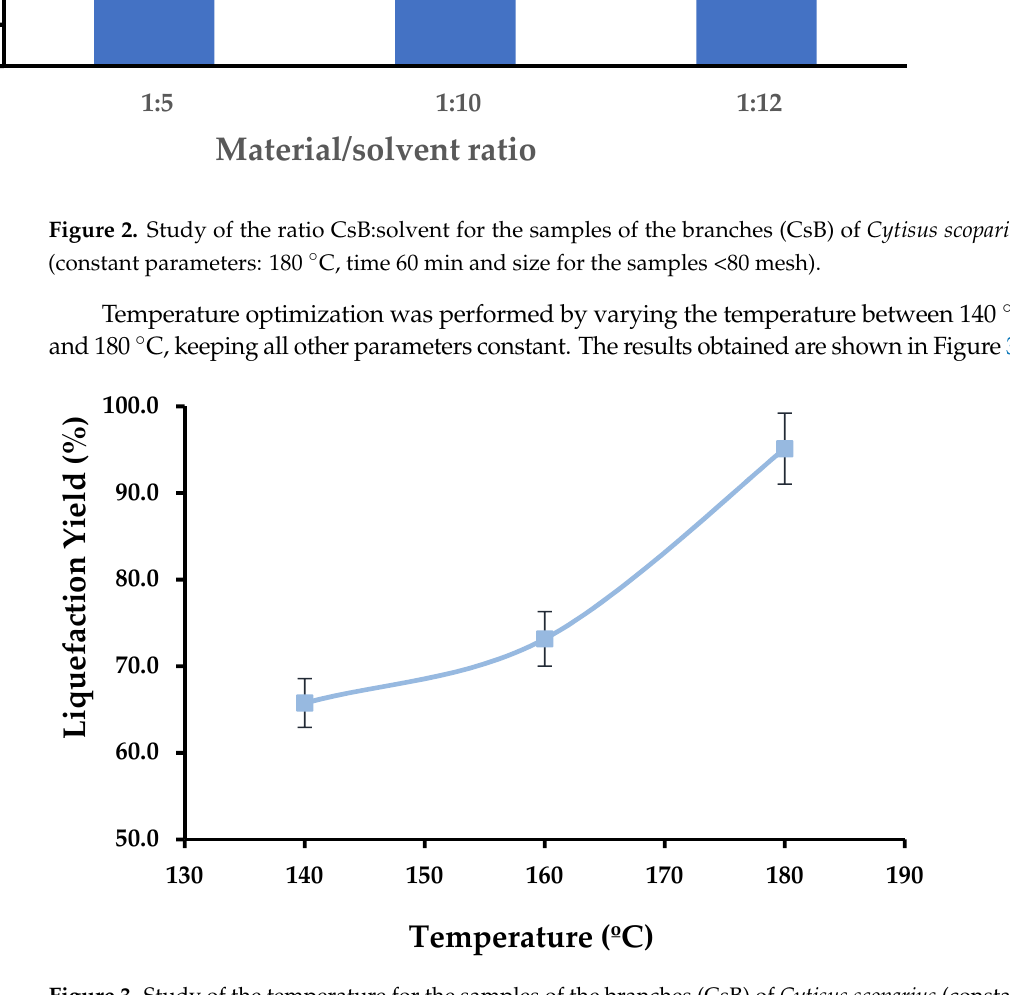
Figure 2. Study of the ratio CsB:solvent for the samples of the branches (CsB) of Cytisus scoparius (constant parameters: 180 °C, time 60 min and size for the samples <80 mesh).